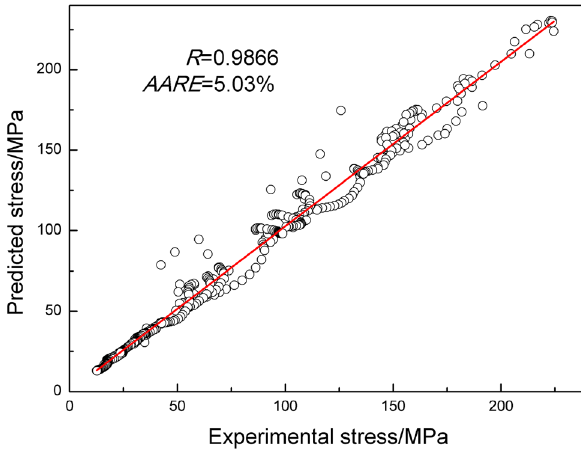
Figure 14: Adiabatic shear band observed at high strain rate of 10 s − 1 .